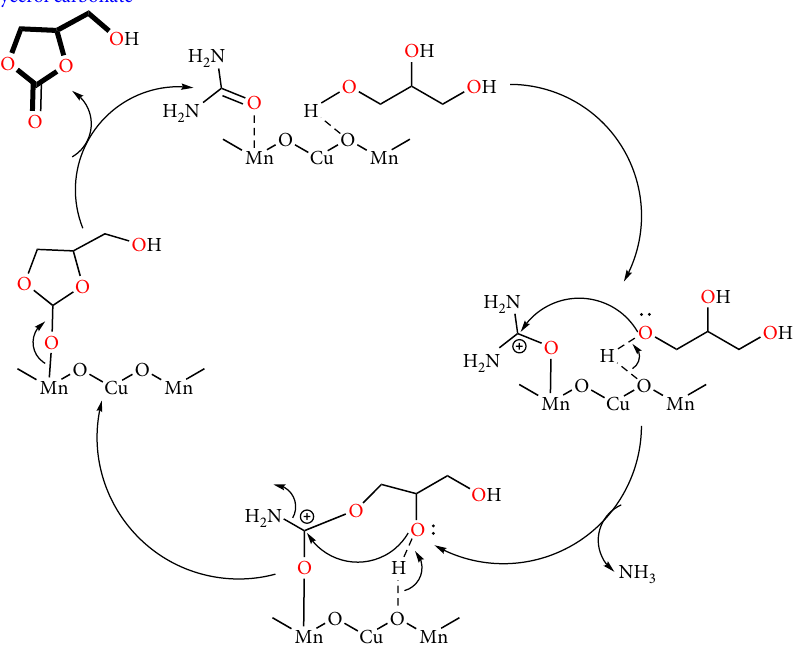
Scheme 12: The possible reaction mechanism for the synthesis of GC by Cu–Mn